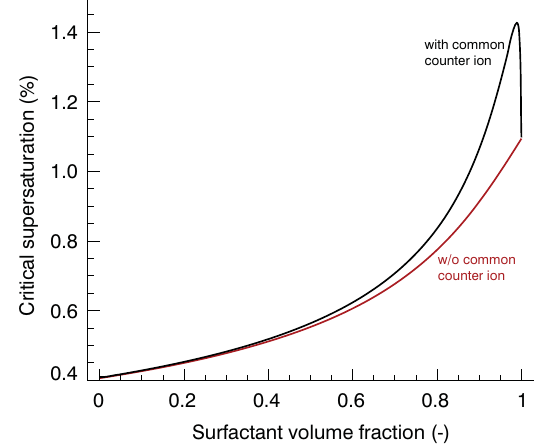
Fig. 2. Apparent hygroscopicity parameter vs. surfactant volume fraction the SDS/NaCl system. Data are taken from Rood and Williams ( (cid:13) , 2001), Sorjamaa et al., ( (cid:3) , 2004), and Prisle et al., ( ♦ , 2010). Kappa was computed from Eq. (1) for each combina- tion of supersaturation and dry diameter reported in the original manuscript. Horizontal bars correspond to ± one standard devia- tion of the retrieved κ app values. The lines show model calculations using the linear mixing rule with apparent kappa as inputs (long dashed line), partitioning theory without common counter ion for D d = 40nm (Eq. 5, short dashed line), and partitioning theory ac- counting for the common counter ion for D d = 40nm (Eq. 8, solid line). The blue and grey shaded region shows the effect of varying the dry diameter between 40 nm <D d < 200nm in the calculations for partitioning